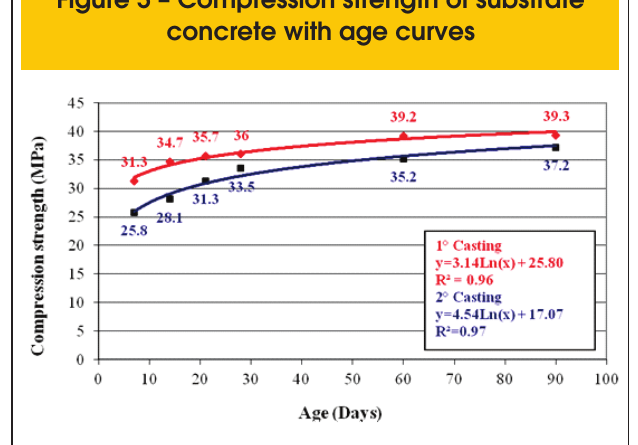
Figure 5 – Compression strength of substrate concrete with age